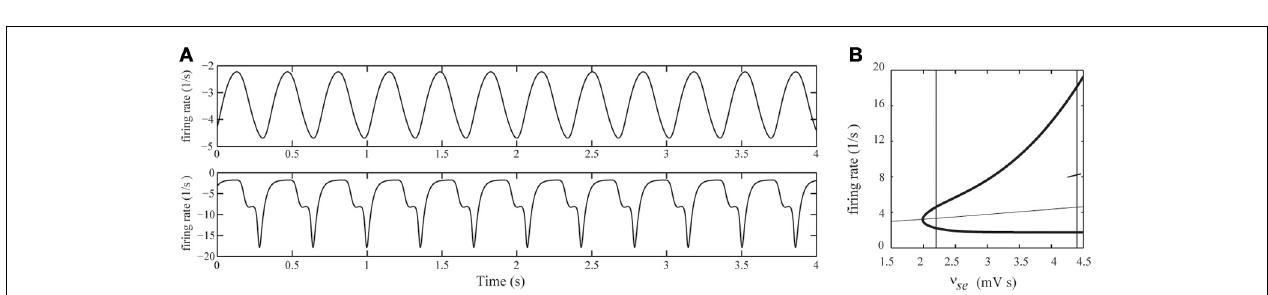
FIGURE 6 | Physiological mechanism suggested to underly the generation of intermittent epileptic spikes. (A) Numerical simulation of the model equations with ν se = 2 . 2mV s, showing four delta cycles. ( V s blue, V r red, and − ϕ e green). (B) Similar to (A) but for ν se = 4 . 4mV s. For visibility, all variables have been scaled by the absolute value of their means. (C) For